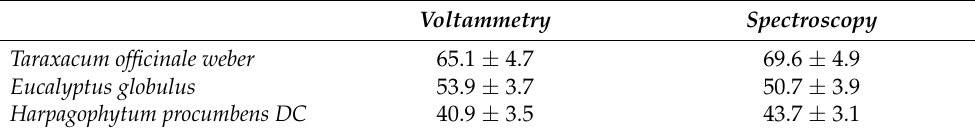
Table 3. Mean values of Tl(I) ( µ g kg − 1 ) for Taraxacum officinale weber, Eucalyptus globulus and Harpago- phytum procumbens DC sold on the market (Portomaggiore, Italy). The determined values are the mean of five independent determinations. Confidence level: